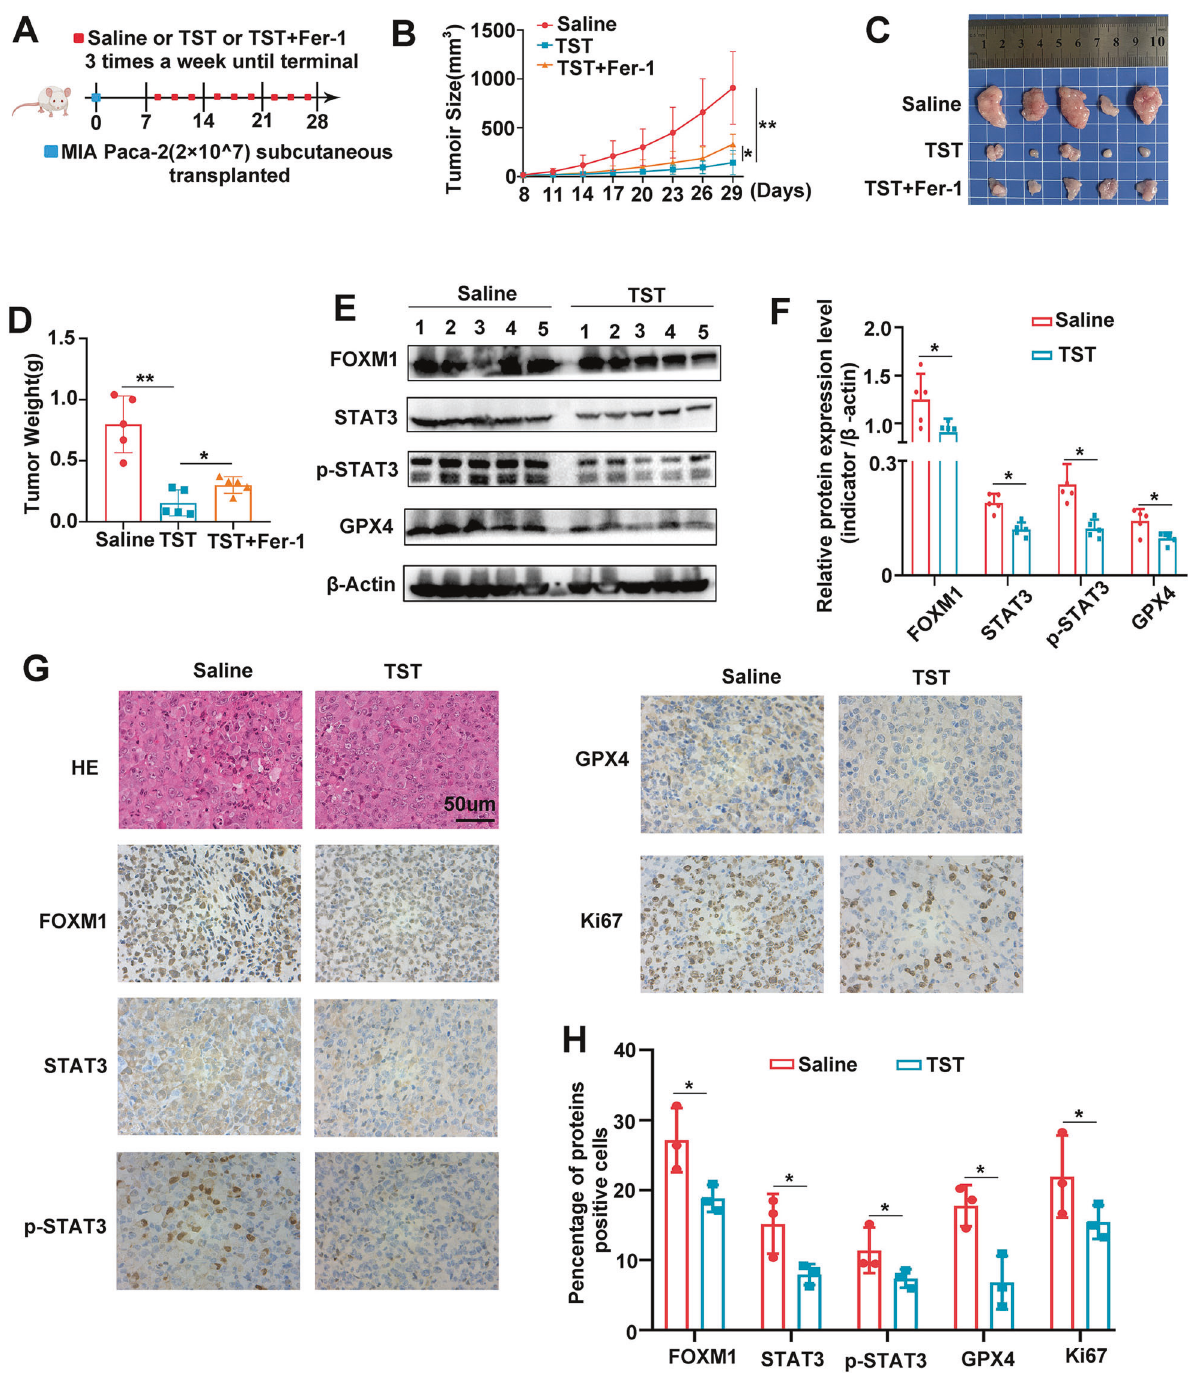
Fig. 5 Thiostrepton bene fi ts to treating pancreatic cancer in vivo. A Once the tumours reached 2 – 3 mm in diameter, the subcutaneous xenograft model mice received different treatments (saline, 17 mg/kg TST, TST + 20 mg/kg Fer-1) three times a week until the experiment was terminated. B The changes in tumour volume were monitored and are shown for animals receiving different treatments. C Representative images of the subcutaneous xenograft model mice. D The average weights of the tumours after different treatments. E and F Western blotting analysis of FOXM1, STAT3, p-STA3 and GPX4 protein levels in tumours from different treatment groups. G and H The level of FOXM1, STAT3, p-STA3, GPX4, and Ki67 proteins in the indicated xenograft tumours by IHC assay (* P < 0.05 and ** P < 0.01). intervention was then used to observe the proliferation of the TST promotes ferroptosis by regulating STAT3-GPX4 signalling. three cell lines, and STAT3 overexpression also partially reversed We overexpressed STAT3 in Panc-1, MIAPaCa-2 and BxPC-3 cells the effect of TST on killing pancreatic cancer cells (Fig. 4C). and then treated the cells with TST to further explore this Similarly, STAT3 overexpression partially rescued the TST-induced hypothesis. An analysis of GPX4 protein and mRNA levels decrease in pancreatic cancer cell clonogenesis (Fig. 4D, E). showed that the TST-induced reduction in GPX4 expression was Subsequently, changes in the levels of ferroptosis-related partially rescued by STAT3 overexpression (Fig. 4A, B). The same Cell Death and Disease (2022)